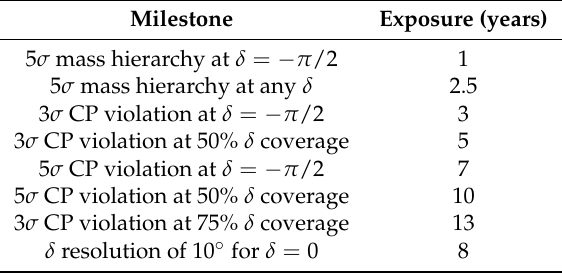
Table 3. Time to achieve the most relevant physics milestones in DUNE for the current detector staging scenario (see